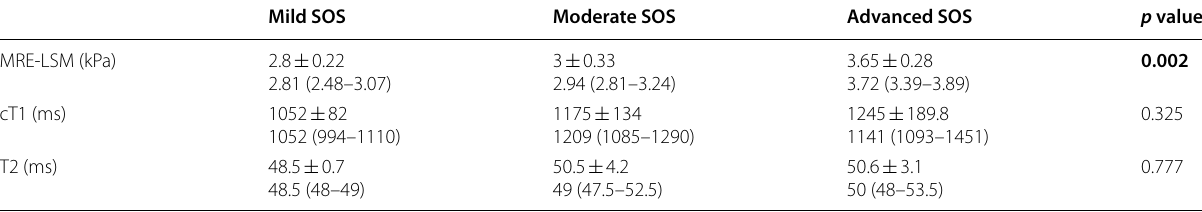
Statistical significant results are highlighted with bold letters Mean standard deviation. Median (interquartile range) ±